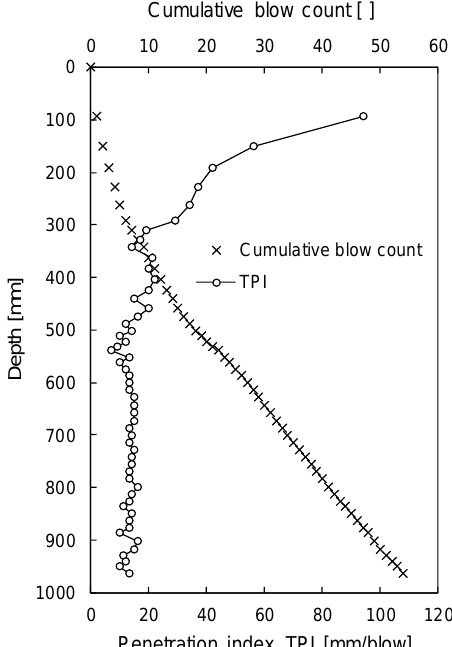
Figure 12. Cumulative blow count and penetration index (TPI) according to penetration depth. Figure 13 shows electromagnetic waves and ground temperatures measured when the center of TDCP wave guides is located at depths from 100 mm to 900 mm with a depth interval of 100 mm. Travel times of electromagnetic waves reflected at the tip of the TDCP wave guides are determined with the tangent analysis method. For depths from 100 mm to 900 mm, the travel time of the reflected electromagnetic waves increases from 1.101 ns to 1.418 ns while the ground temperature decreases from 20.1°C to 15.4°C. Note that the air temperature in this study site was measured at 23.0°C.